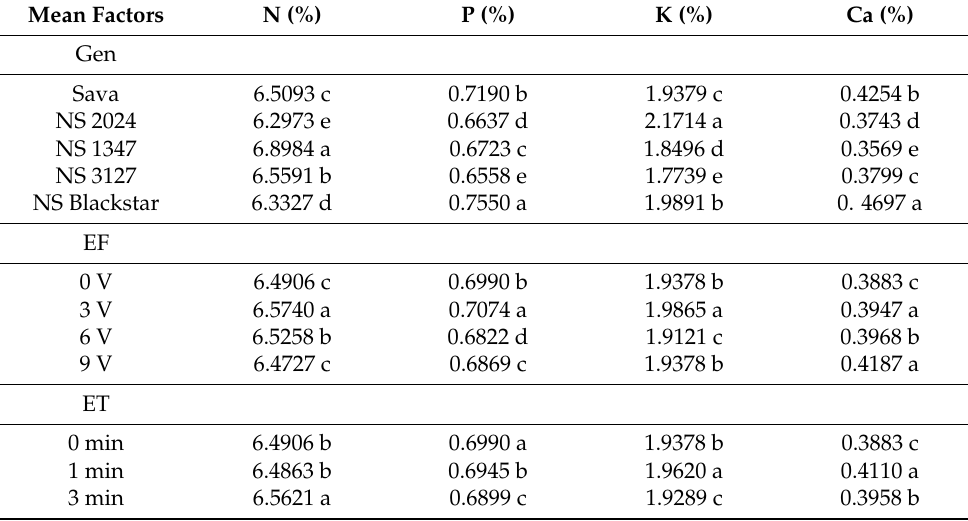
Table 5. The effect of electrostatic field on nitrogen (N), phosphorus (P), potassium (K), and calcium (Ca) content in soybean